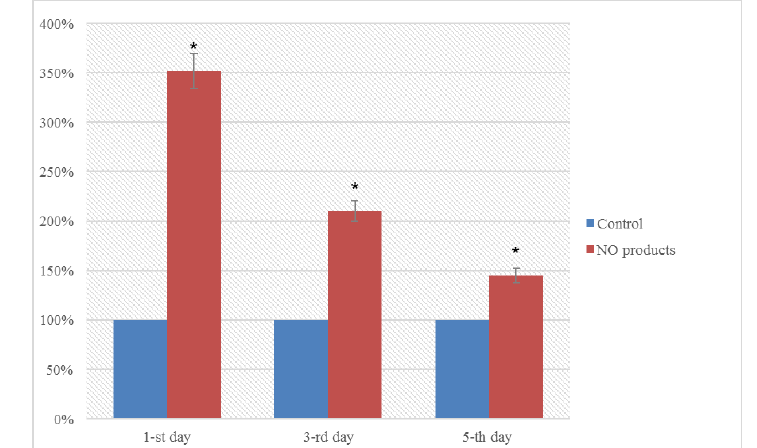
Fig. 1. NO products in the blood of animals with adrenaline-induced myocardial injury under immobilization stress (in % of control): * – p<0.05 compared to the indicator in the control group